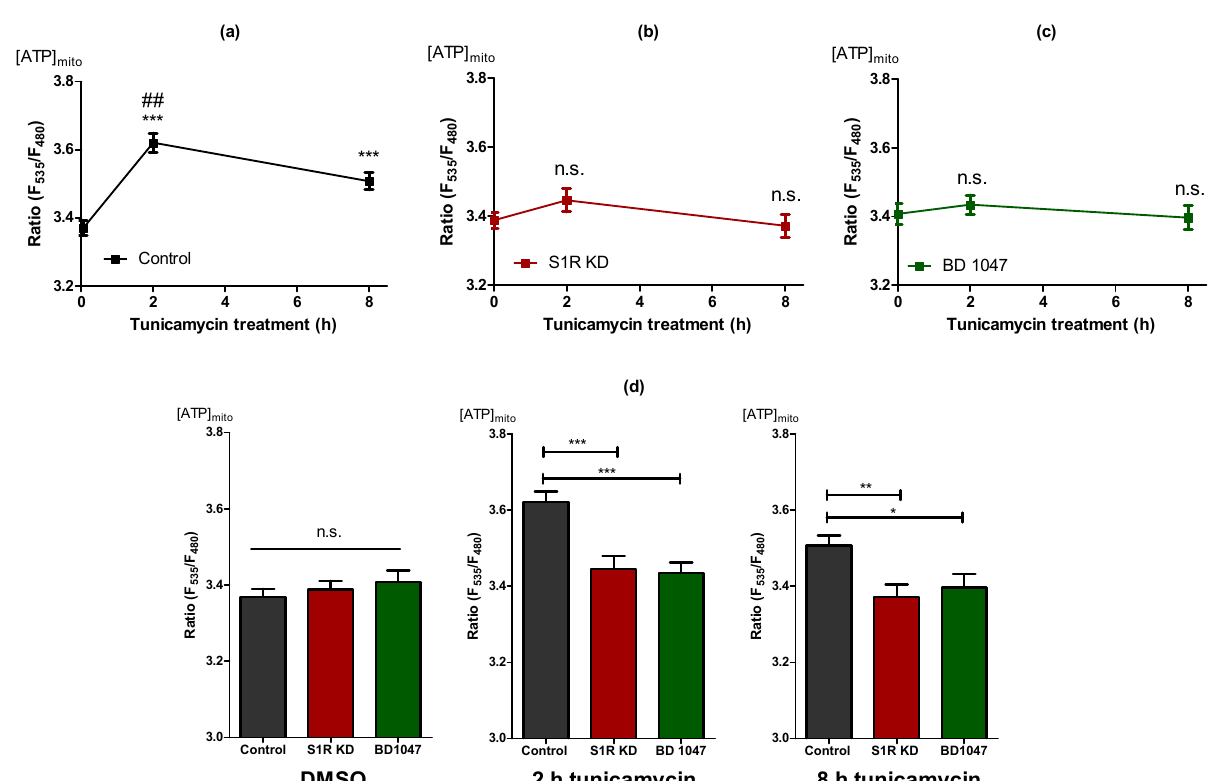
Figure 2. The increase in mitochondrial ATP levels during early ER stress is dependent on S1R. Time course of mitochondrial ATP levels after tunicamycin treatment, presented as mean ± SEM and assessed by the mitochondrial-targeted ATP biosensor AT1.03 in control SH-SY5Y cells ( a ), in cells with S1R KD ( b ) or after treatment with BD 1047 ( c ). ( d ) Bar graphs represent MEAN ± SEM of mitochondrial ATP levels in control (black), S1R KD (red), and BD1047 treated (green) cells before tunicamycin treatment (left), after 2 h (middle), or 8 h (right) tunicamycin treatment. One-way ANOVA with Tukey’s multiple comparison test, * p < 0.05, ** p < 0.01, *** p < 0.001, ## p < 0.001 (comparison between control cells after 2 h and 8 h tunicamycin treatment), n.s.—not significant; Control DMSO (174 cells/18 experiments), Control 2 h tunicamycin (97 cells/10 experiments), Control 8 h tunicamycin (120 cells/11 experiments), S1R KD DMSO (141 cells/15 experiments), S1R KD 2 h tunicamycin (67 cells/7 experiments), S1R KD 8 h tunicamycin (74 cells/8 experiments), BD1047 DMSO (93 cells/9 experiments), BD1047 2 h tunicamycin (80 cells/7 experiments), BD1047 8 h tunicamycin (100 cells, 9 experiments).